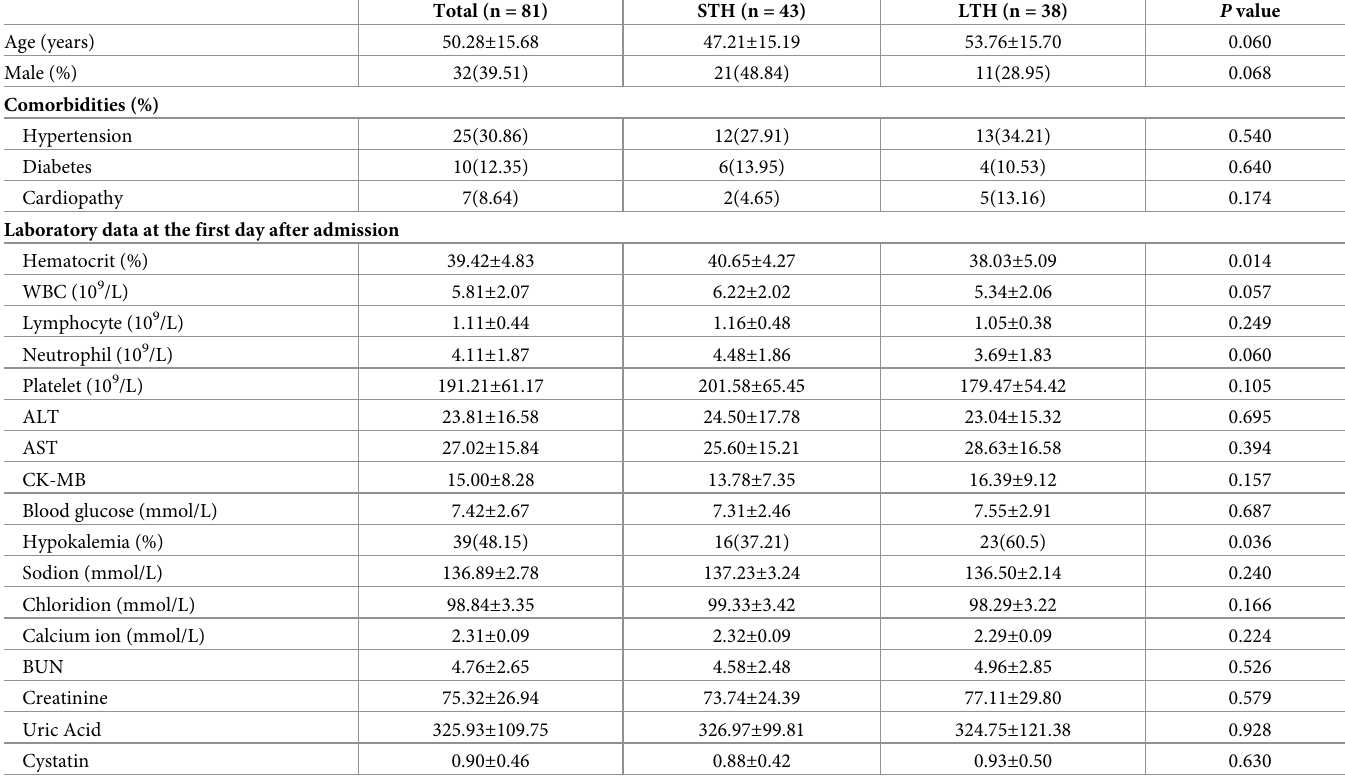
Table 3. Data of the included patients with moderate COVID-19 in STH group and LTH